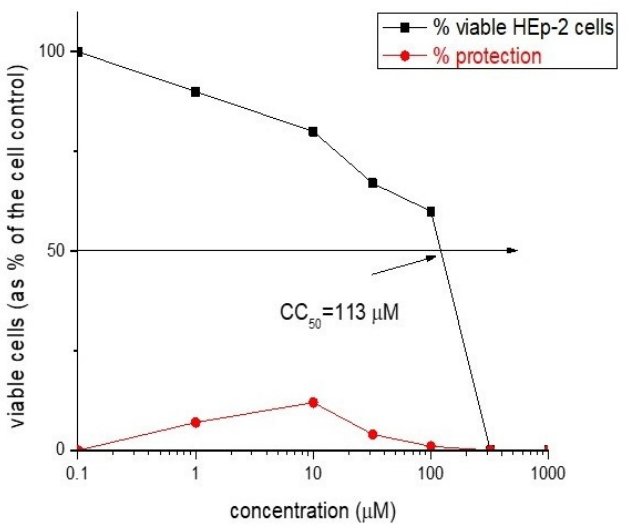
Figure 13. Antiviral activity curve (in red) and cytotoxicity curve (in black) activity of Rh-3. Our experimental data suggest that in the new hybrid peptide compounds containing The cytotoxicity data and antiviral activity of the compounds against human respir- a rhodamine B residue, not only the position of the modification but also the nature and atory syncytial virus (HRSV-S2) and human adenovirus C serotype 5 (HAdV-5) in HEp-2 length of the amino acid sequence leads to significant changes in peptide activity and cell culture are shown in Table 4. affinity. The results suggest that incorporation of different amino acids at the N-terminus of the hemorphin-4 scaffold deserve further evaluation in antiviral and virucidal Table 4. Cytotoxicity and antiviral activity of new rhodamine-peptides against human respiratory